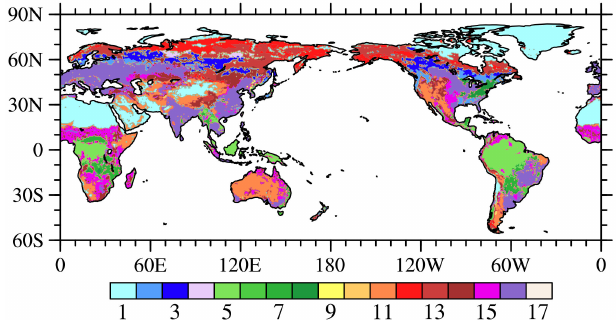
Figure 1. Global plant functional types (PFT) distributions from the Moderate Resolution